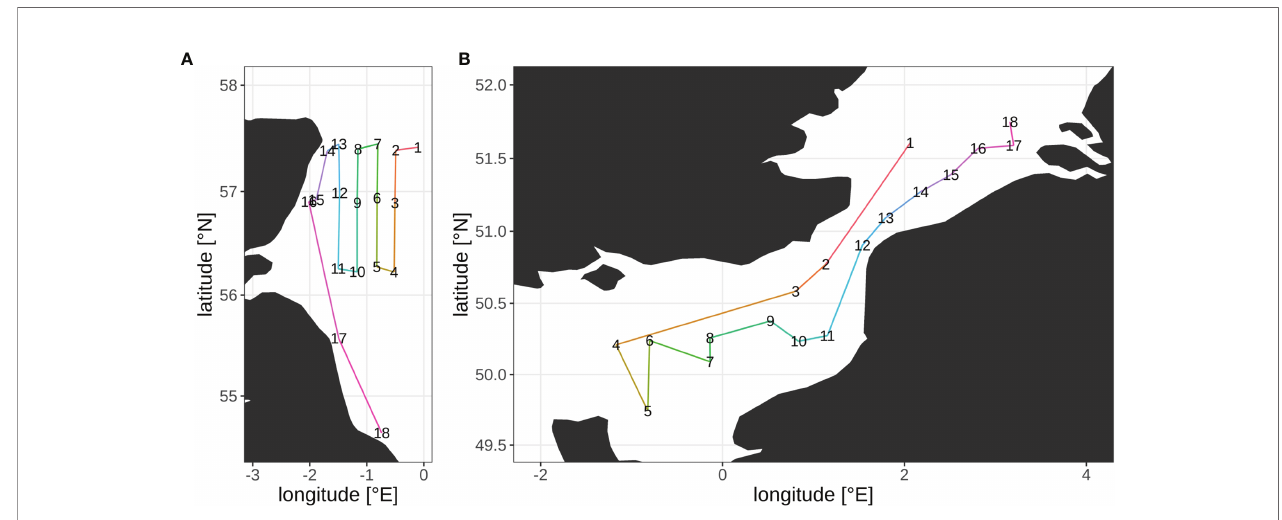
FIGURE 3 | Survey transects and location of the sampling stations from the September (A) and December (B)